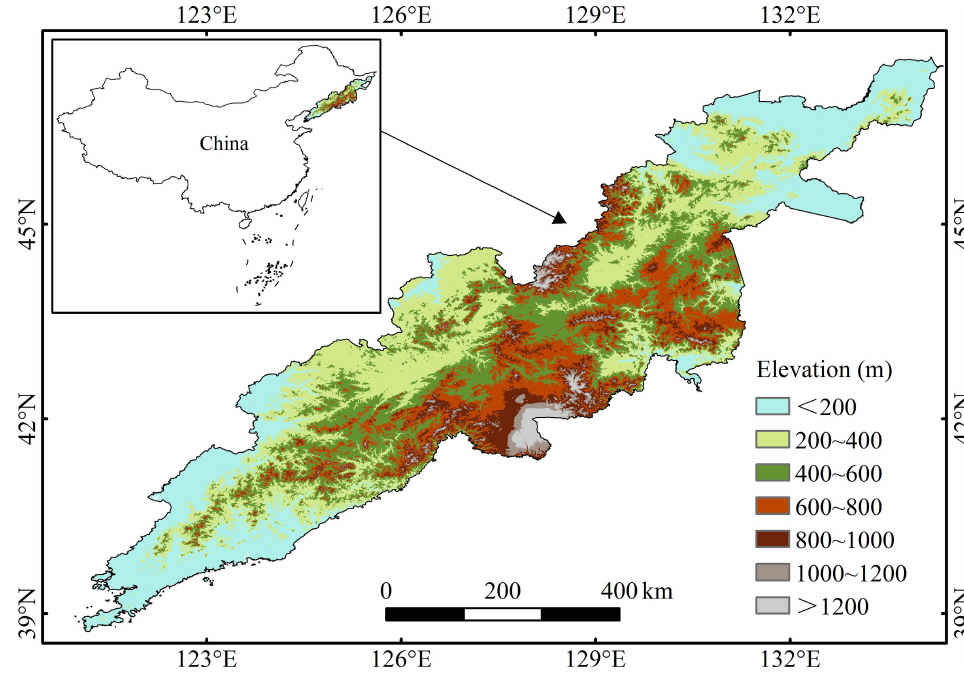
Figure 1. The location and elevation of Changbai